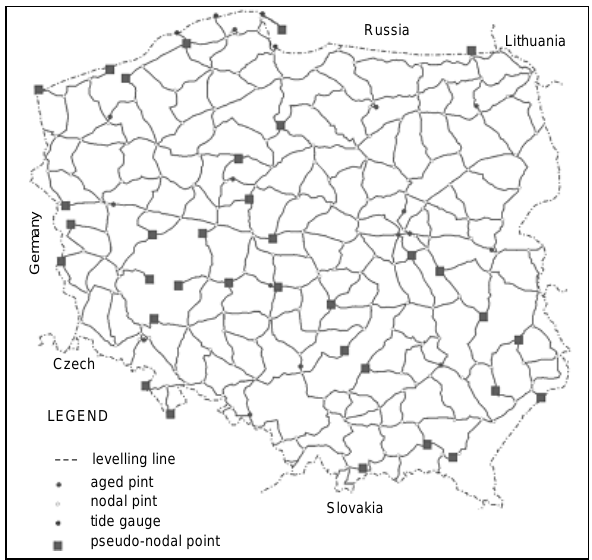
Fig 4. Common nodal points and pseudo-nodal